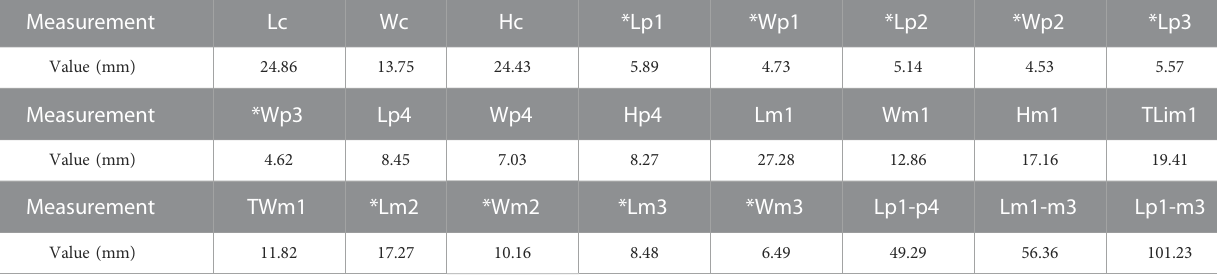
TABLE 2 Measurements of the mandible of L. qiui gen. et sp. nov. (IVPP V 28616) (mm). Abbreviations: HVR, height of the vertical ramus (from the apex of the coronoidtothemostventralpointoftheangularprocess);MHVR,middleheightoftheverticalramus(fromthedeepestpointofthemandibularnotchtothemost ventral point of the angular process); LM, length of the mandible; MAT, moment arm of the temporalis muscle; Cm3, distance between the condyle and the posterior margin of m3; DMm3, depth of the mandible on the posterior margin of m3; WMm3, width of the mandible on the posterior margin of m3. Measurement